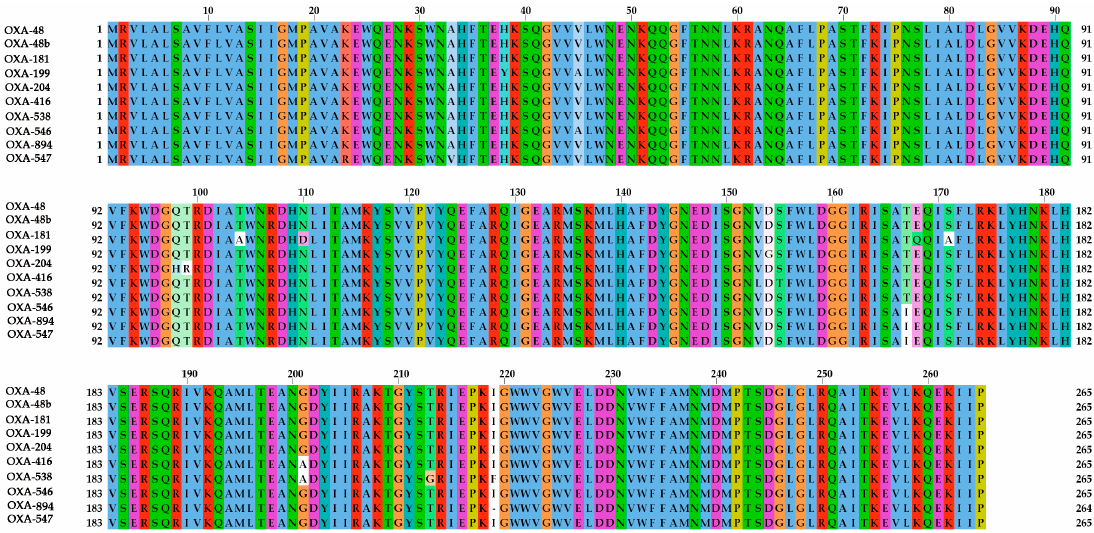
Figure 1. Alignment of the amino acid sequences of OXA ‐ 48 (WP_015059991), OXA ‐ 48b (AGS78031), OXA ‐ 181 (AQU42625), OXA ‐ 199 (WP_063861505), OXA ‐ 204 (AGS78037), OXA ‐ 416 (APO14326), OXA ‐ 538 (WP_071593227), OXA ‐ 546 (WP_087587945), OXA ‐ 894 (MN525568) and OXA ‐ 547 (WP_085562403).